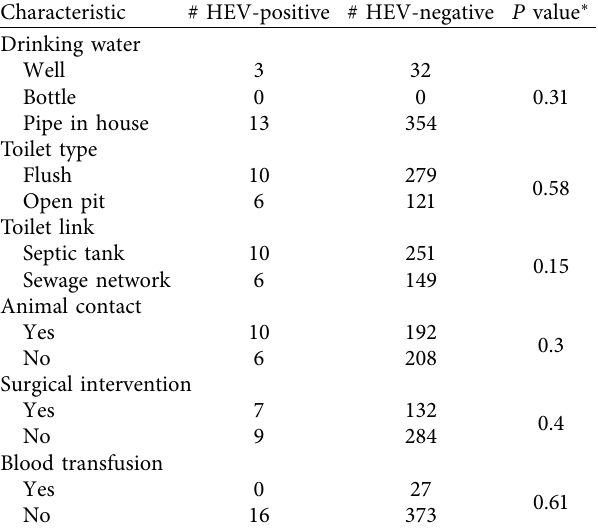
Table 4: Clinical history and personal hygiene risk factors of HEV IgG positive participants.